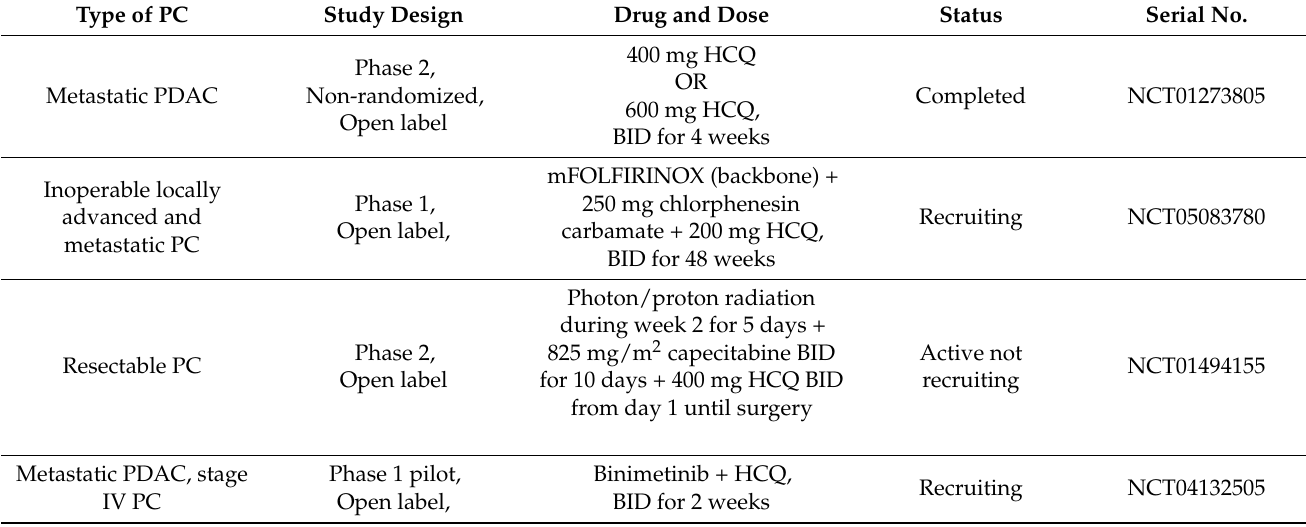
Table 1. Current clinical trials using chloroquine or hydroxychloroquine to treat PDAC. (Source: clinicaltrial.gov, accessed on 28 June